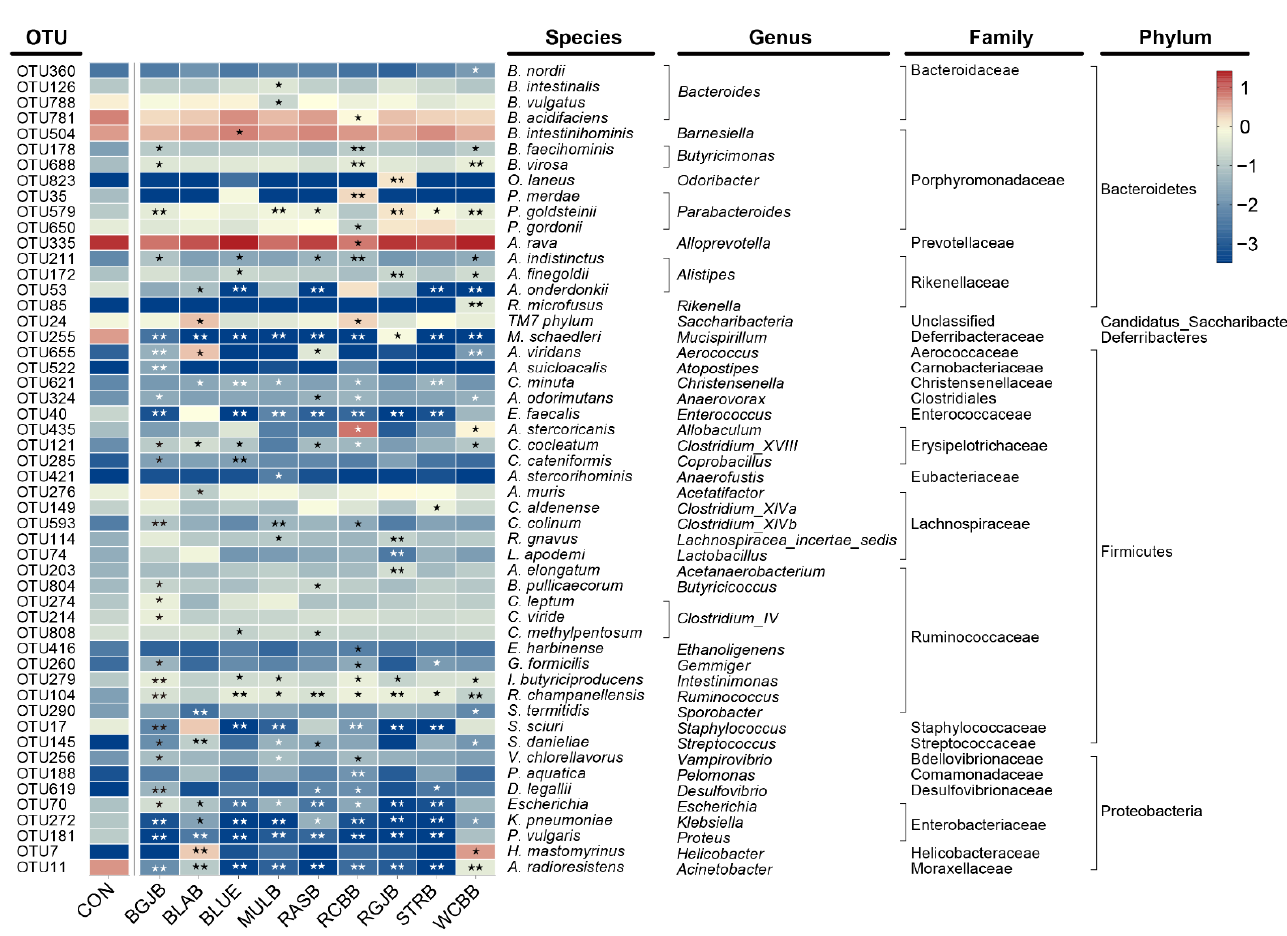
Figure 7. Heatmap of the bacterial species significantly altered by each berry administration. Statistical significance was determined by Mann-Whitney U test for two groups comparisons. *, compared with control group. *, p < 0.05; **, p < 0.01. (n = 7/group).